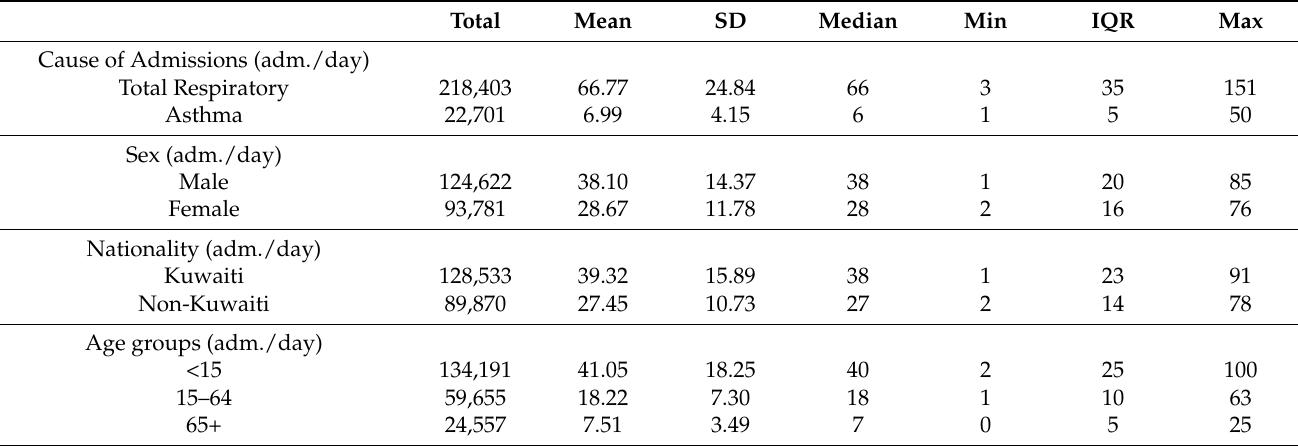
Table 1. Descriptive statistics of the population and environmental exposures over the study